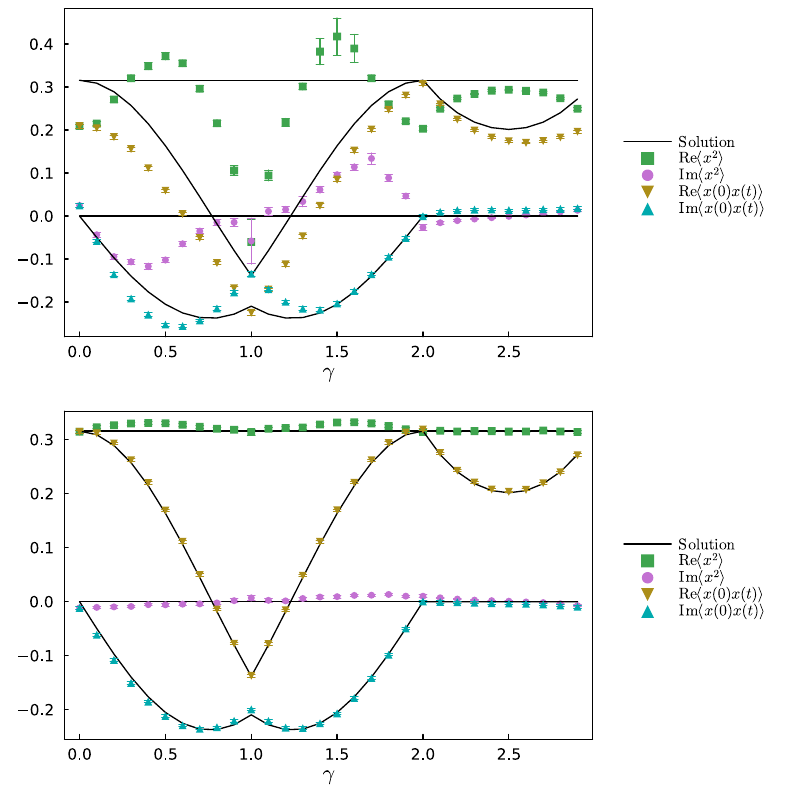
Figure 4 . Anharmonic oscillator at m = 1 and λ = 24 up to t max = 1 in real-time without (top) and in the presence (bottom) of the heuristic free theory kernel with g = 0 . 8 and m eq. (3.28). Both simulations are carried out generating 100 trajectories simulated up to mτ in Langevin time, saving configurations at every m ∆ τ solver with θ = 1 . 0 without kernel (top), and θ = 0 . 5 with kernel (bottom). Values of the correlators from the solution of the Schrödinger equation are given as solid black